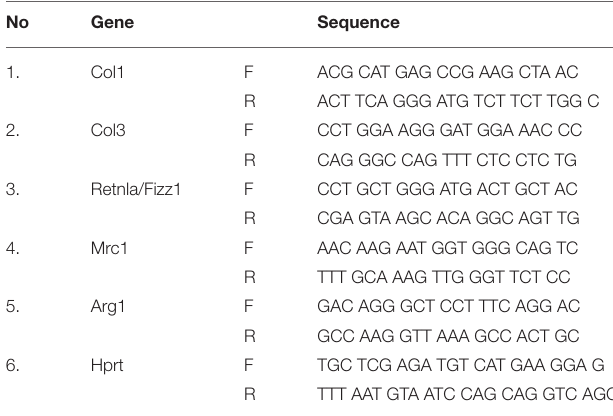
TABLE 1 | Mouse primers used for